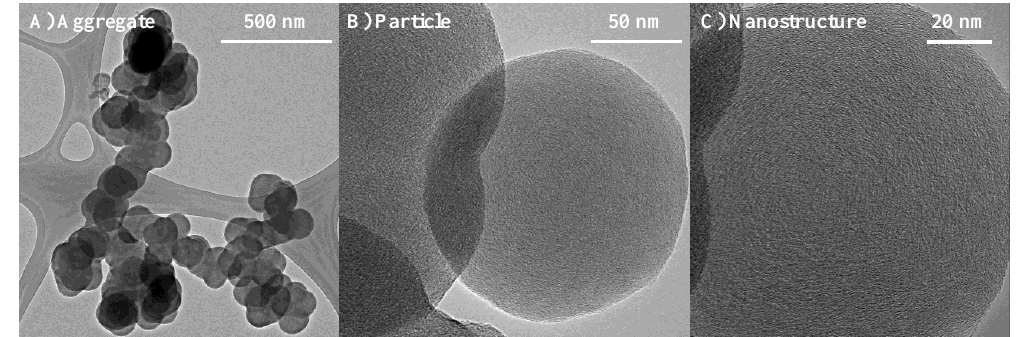
Figure 3. Transmission electron micrographs showing the three length scales: ( A ) aggregate, ( B ) primary particle, and ( C ) nanostructure for lamp black.